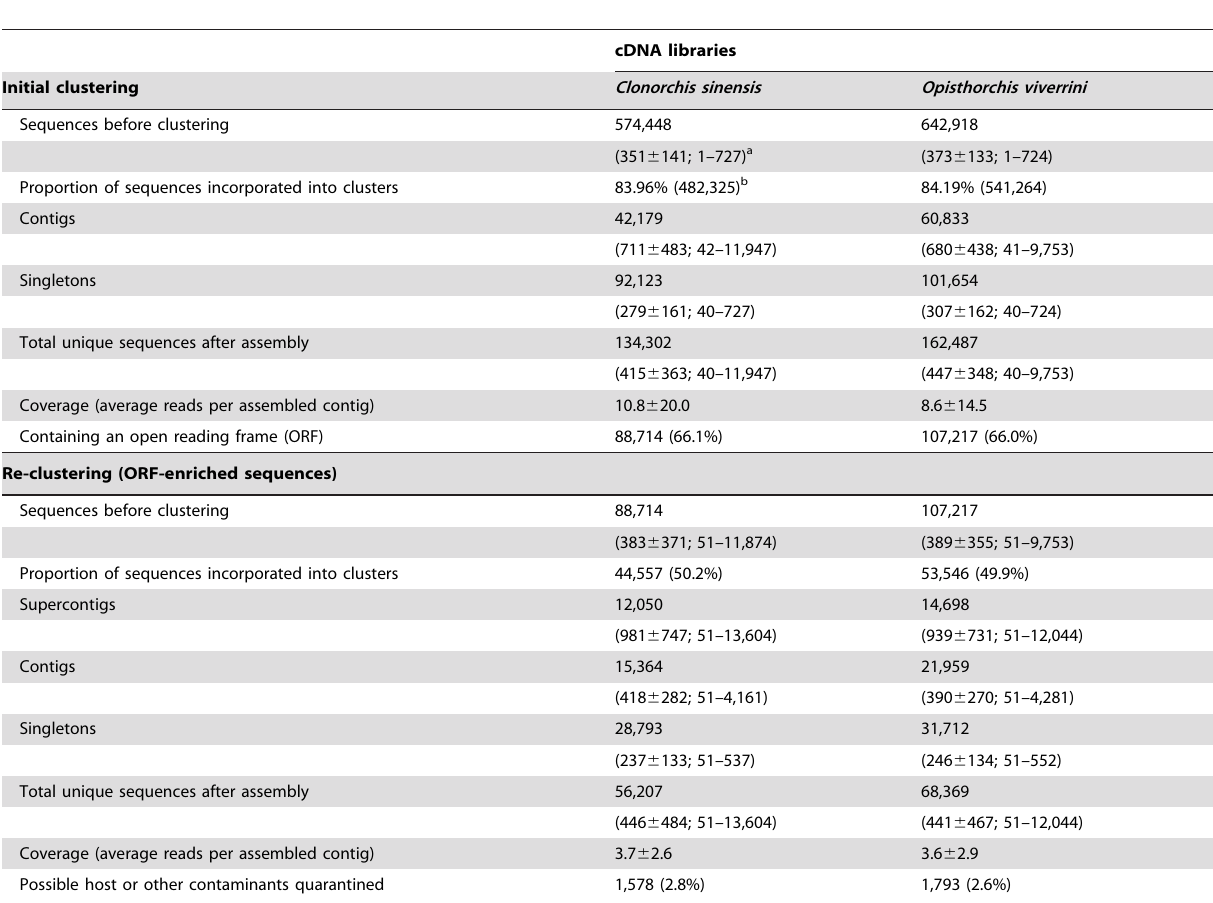
Table 1. Summary of the clustering performance and bioinformatic analyses performed on the nucleotide sequences encoded in the transcriptome of the adult stage of each Clonorchis sinensis and Opisthorchis viverrini